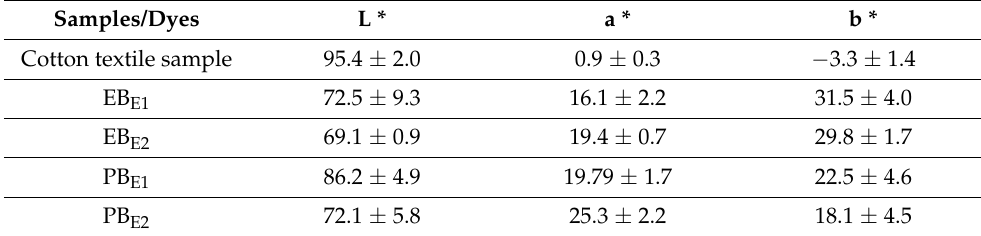
Table 3. Color evaluation of the textile cotton samples dyed with EB E and PB E .